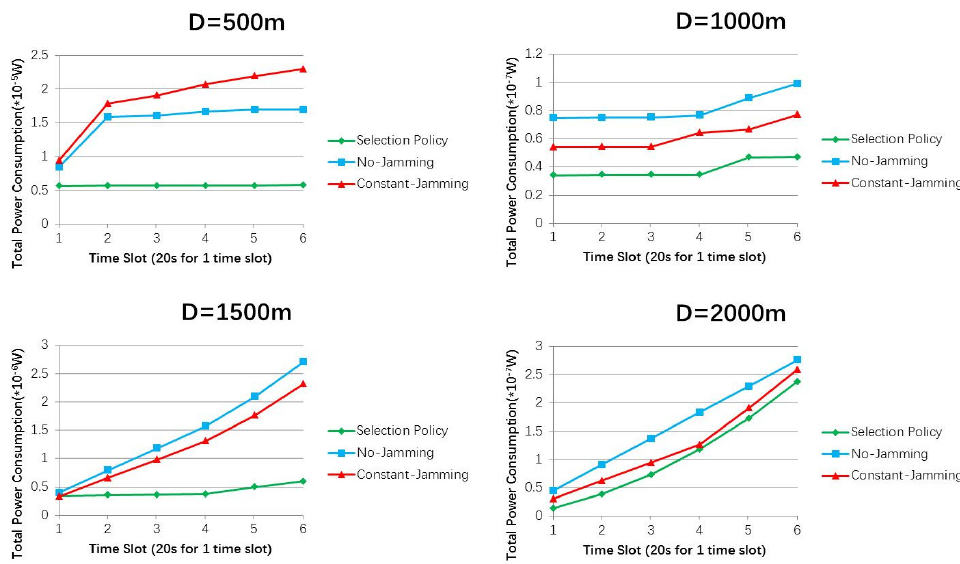
Figure 6. Total power consumptions by UAV L in different Ds with different jamming methods.